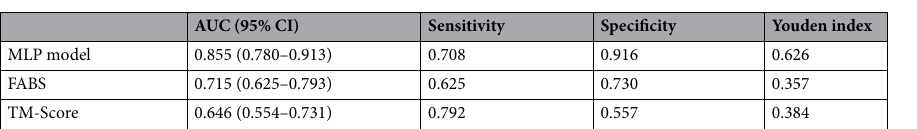
Table 2. Comparison of the predictive performance of the MLP model and previous published scales in the testing